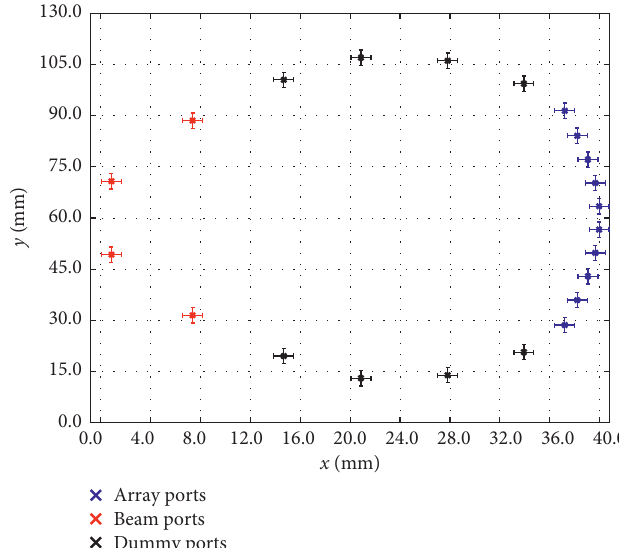
Figure 9: C-band Rotman lens: port positions and position tolerances after IA refinement.